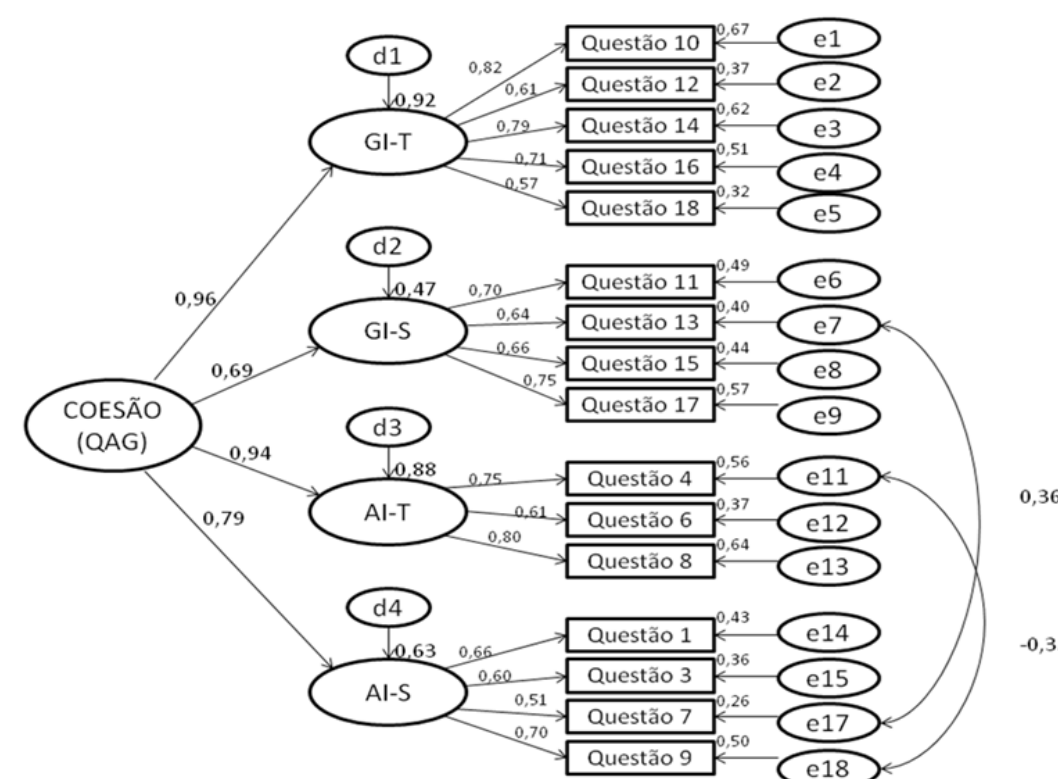
Figura 1. Carga fatorial, intercorrelações entre fatores e erro associado a cada item, no modelo de quatro fatores, com 16 itens da versão brasileira do Group Environment Questionnaire (GEQ).